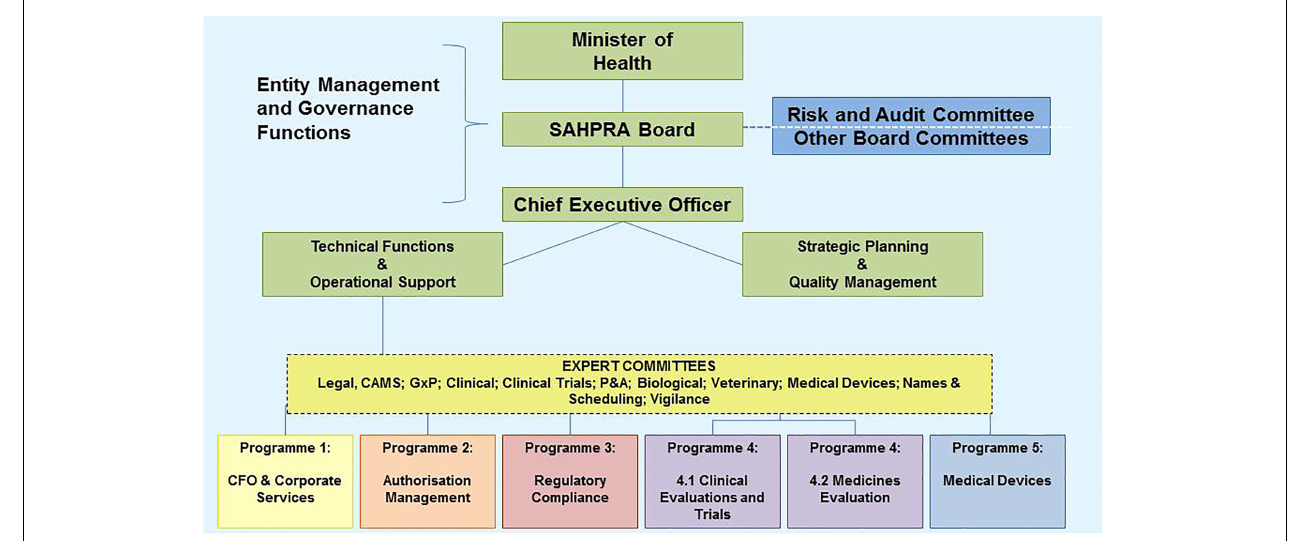
FIGURE 3 | Transitional organizational structure of the South African Health Products Regulatory